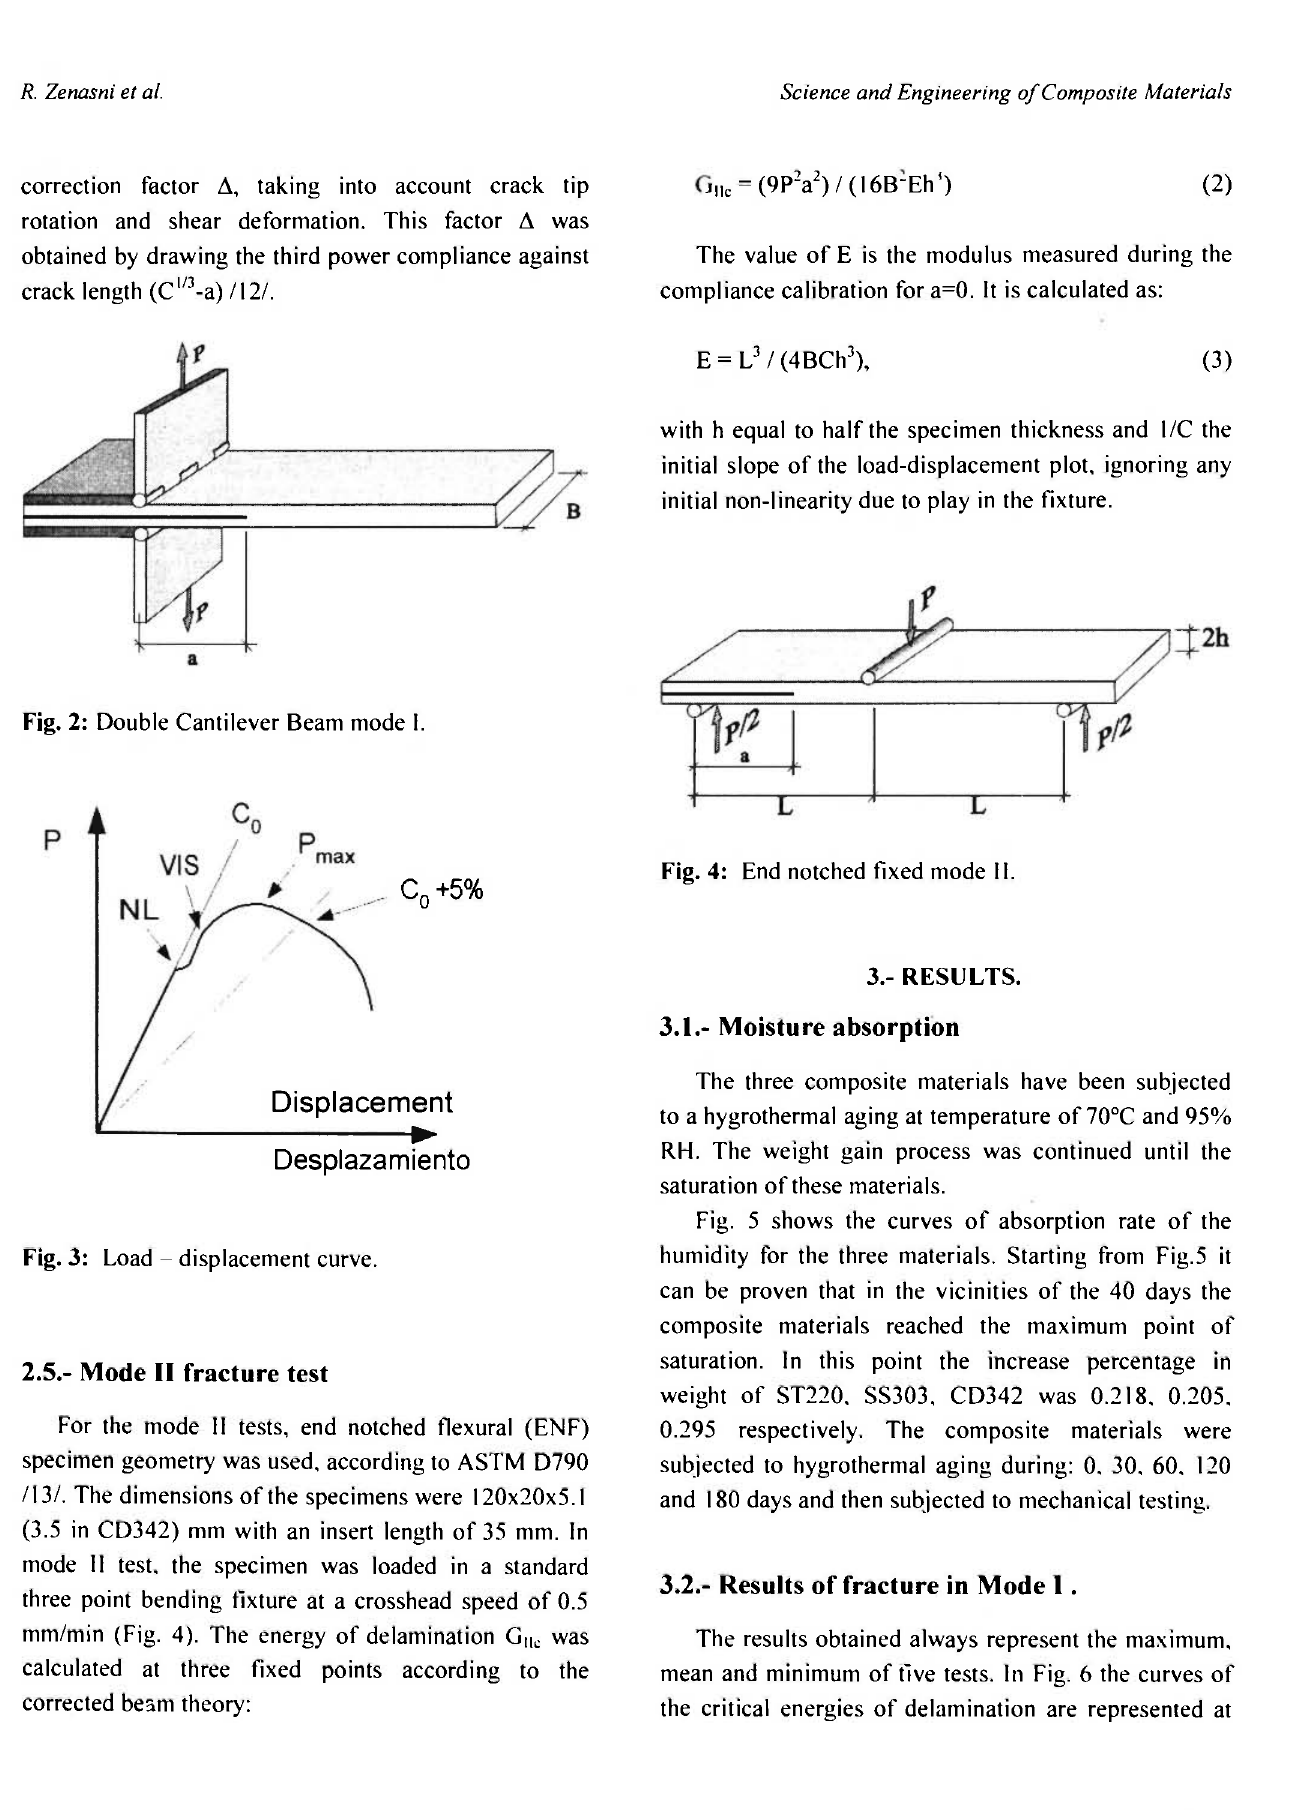
Fig. 2: Double Cantilever Beam mode I.